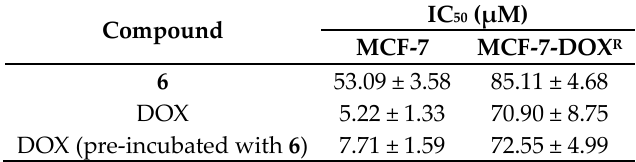
Table 1. Effect of curcuminoid pyrazoline 6 on DOX sensitivity in MCF ‐ 7 and MCF ‐ 7/DOX R